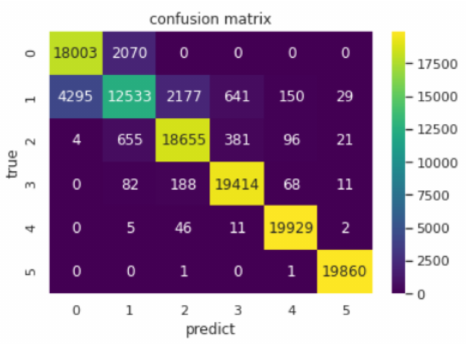
Figure 11. Confusion matrix of testing set.